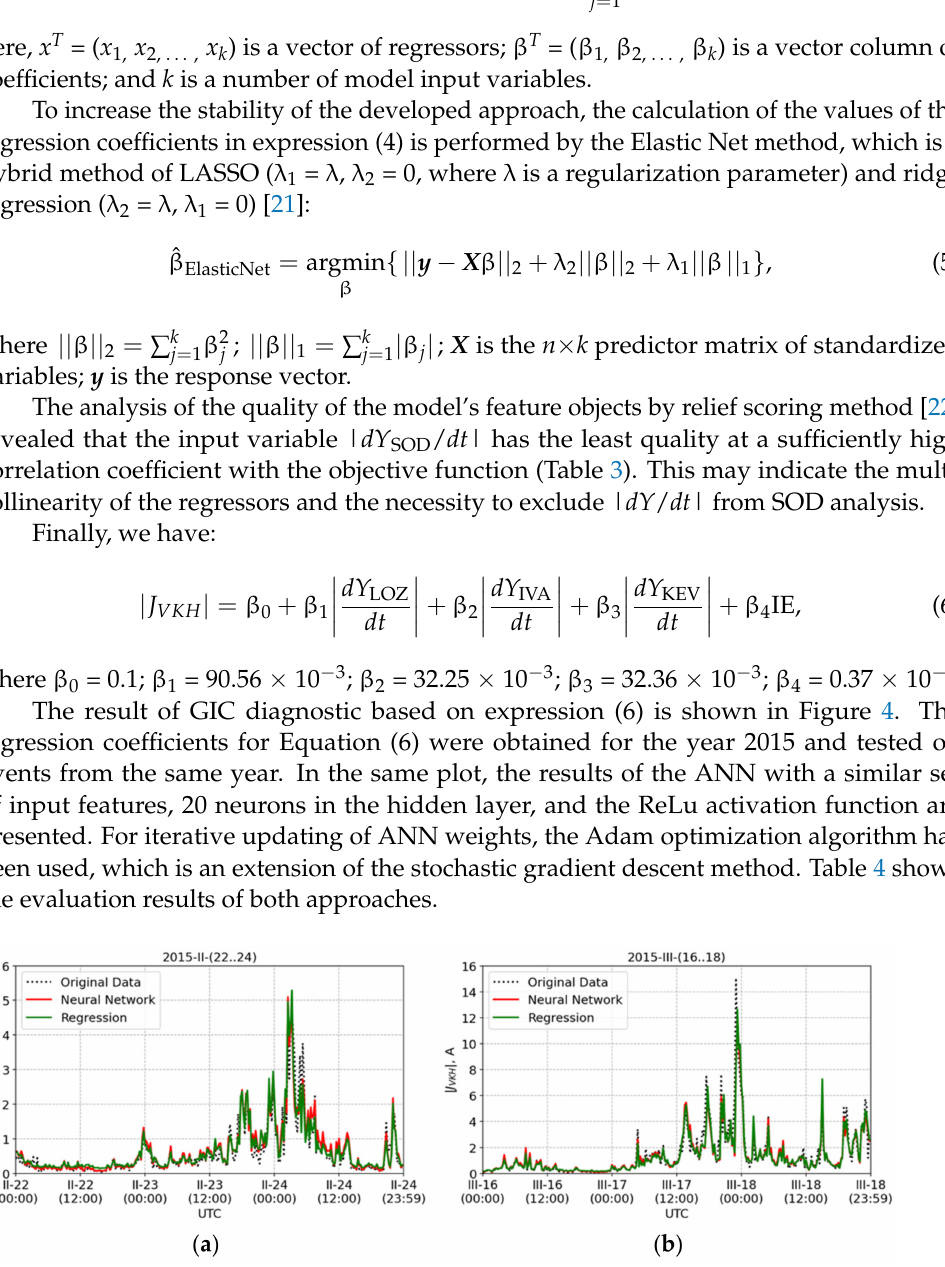
Figure 4. Estimation of the GIC level | J VKH | using the regression and ANN models for the magnetic storm of 24 February 2015 (Kp = 5) ( a ) and 17 March 2015 (Kp = 8) ( b ). Table 4. Quality metrics for different approaches to the GIC